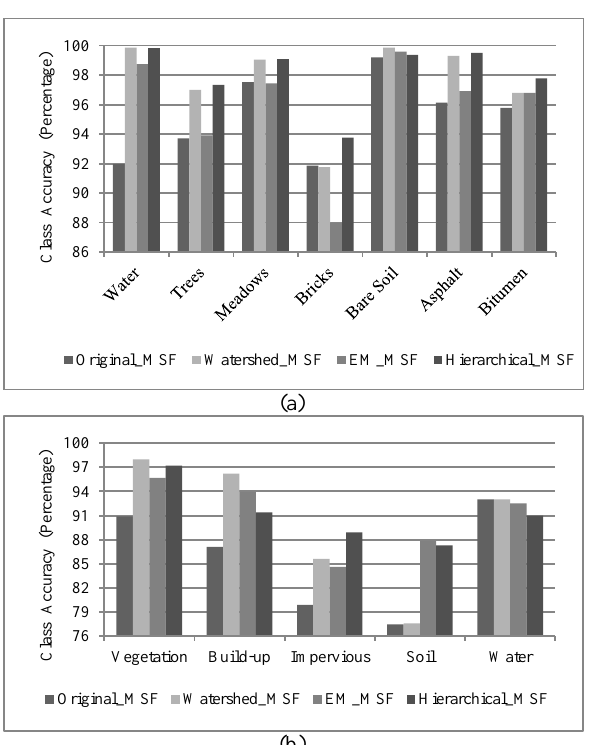
Figure 6. The producer’s accuracy of the landcover classes for (a) Washington DC Mall and (b)